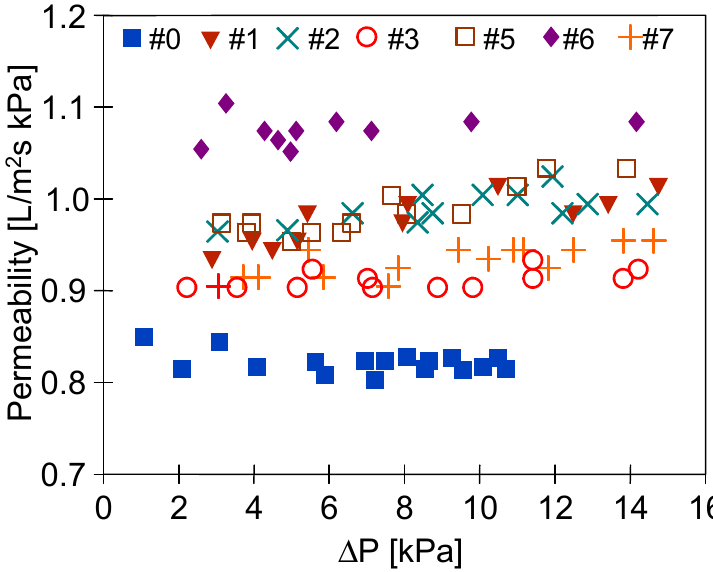
Figure 13. Permeability of membranes treated by plasma (non-used).